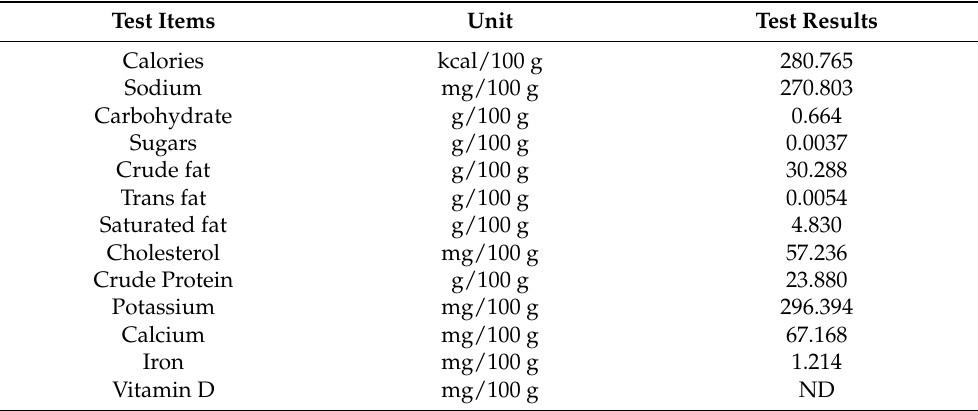
Table 1. The nutritional quality of hot smoked CM fillet.